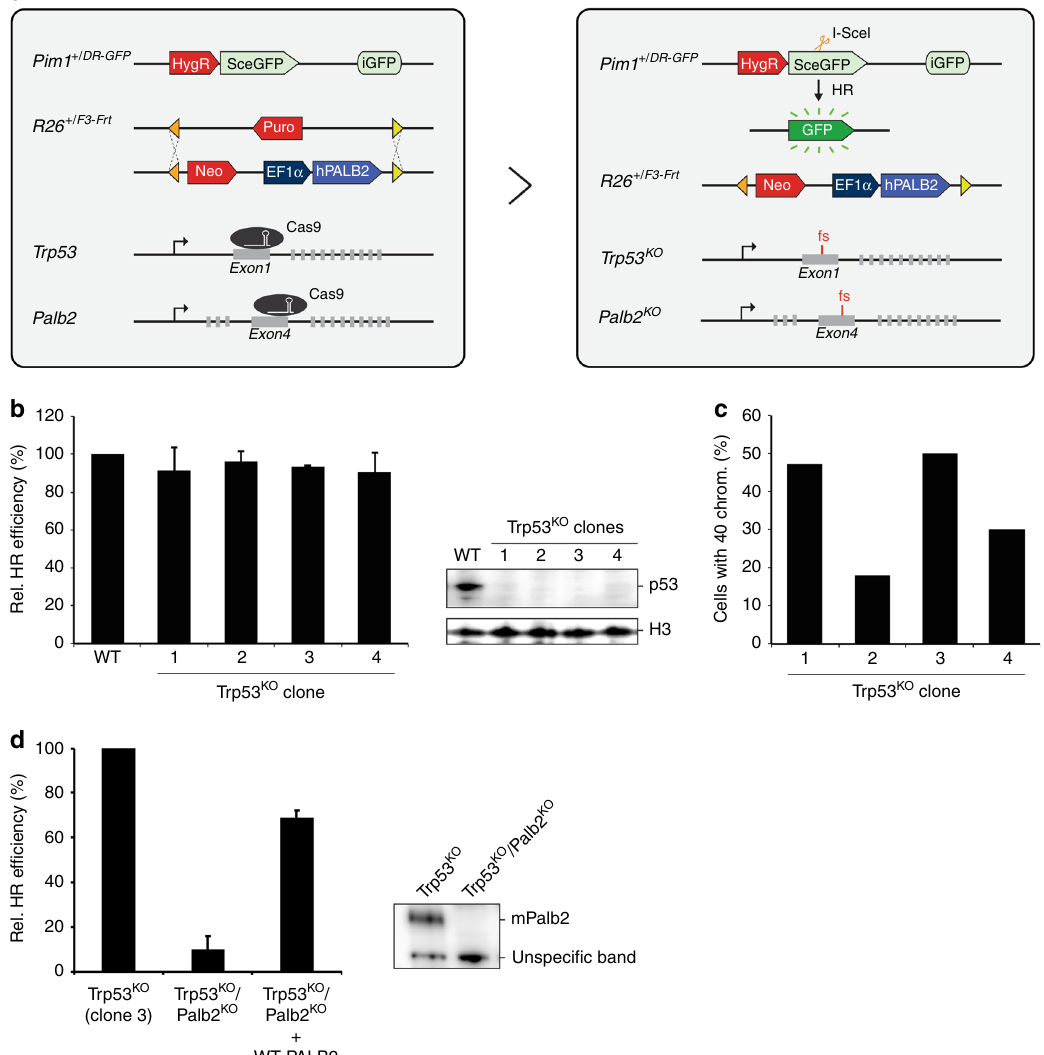
Fig. 1 Development of a cDNA-based complementation system for the functional analysis of human PALB2 . a Schematic of the cDNA-based complementation system for functional analysis of human PALB2 . The DR-GFP reporter for HR and recombination-mediated cassette exchange system (RMCE) for site-speci fi c integration and expression of a human PALB2 cDNA were incorporated at the mouse Pim1 and Rosa26 ( R26 ) loci, respectively. Endogenous mouse Trp53 was targeted with CRISPR/Cas9 using a gRNA against exon 1, whereas endogenous Palb2 was targeted with a gRNA against exon 4 (left). Transient expression of the I-SceI endonuclease in Trp53 KO /Palb2 KO cells expressing human PALB2 cDNA (with or without a variant) allows for assessment of the HR ef fi ciency using the DR-GFP reporter (right). b DR-GFP assay in Trp53 KO mES cell clones transfected with an I-SceI and mCherry co-expression vector. GFP expression was monitored by Fluorescence-Activated Cell Sorting (FACS). Data represent mean percentages (±SEM) of GFP- positive cells among the mCherry-positive cells relative to that for the wild type (WT), which was set to 100%, from two independent experiments (left). Western blot analysis of Trp53 expression in 4 Trp53 KO mES cell clones. Histone 3 (H3) was a loading control (right). c Karyotyping of Trp53 KO mES clones from ( b ). The bar graph shows the percentages of cells with 40 chromosomes ( n = 50 cells per condition). d DR-GFP assay in Trp53 KO and Trp53 KO / Palb2 KO mES cells expressing WT PALB2 or not. Cells were transfected with an I-SceI and mCherry co-expression vector. GFP expression was monitored by FACS. Data represent mean percentages (±SEM) of GFP-positive cells among the mCherry-positive cells relative to that for Trp53 KO cells, which was set to 100%, from four independent experiments (left). Western blot analysis of mouse (m)Palb2 expression in Trp53 KO and Trp53 KO /Palb2 KO (clone 3) mES cells (right). An unspeci fi c band was a loading control (right). Source data are provided as a Source Data fi